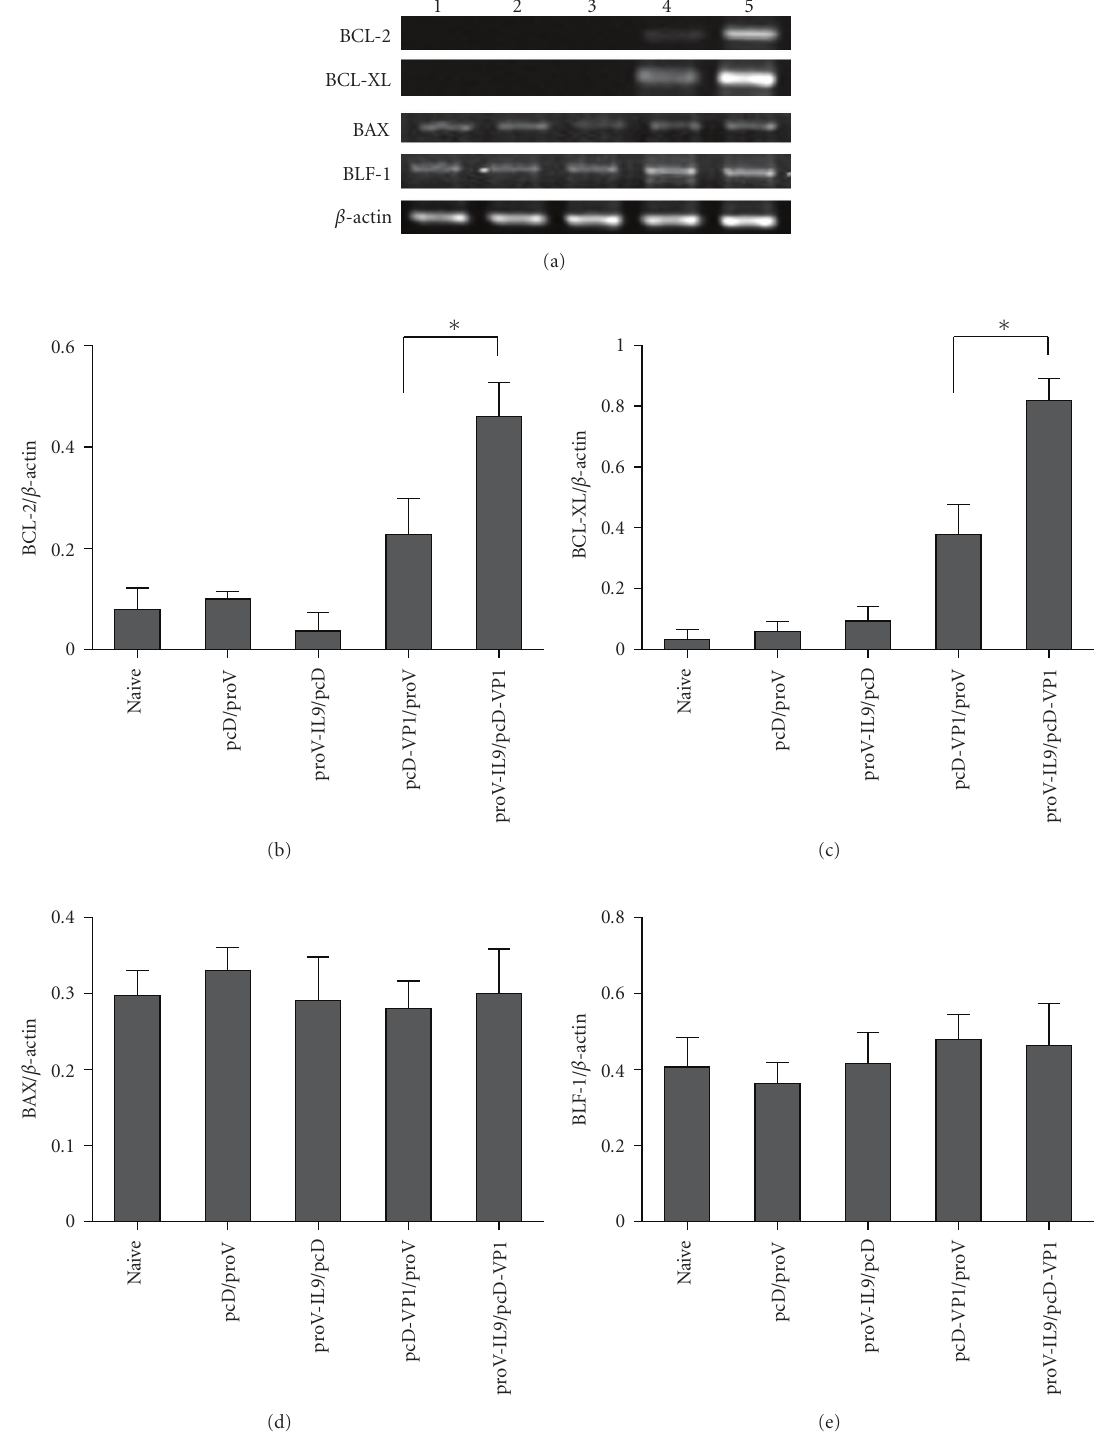
Figure 5: Expression of apoptotic or proapoptotic genes in CD8 + T cells by RT-PCR. Total RNA was isolated from the splenic CD8 + T cells of immunized on day 7 after final boost. (a) The expression levels of apoptotic or proapoptotic genes were semiquantitatively measured by RT-PCR through the normalization of the tested cDNA concentration to the amount of β -actin. (b), (c), (d), (e) the density of each band as determined using Alpha image software and expressed as a relative intensity against the β -actin band. From left to right, 1, na¨ıve; 2, pcD/proV; 3, proV-IL9/pcD; 4, pcD-VP1/proV; 5,